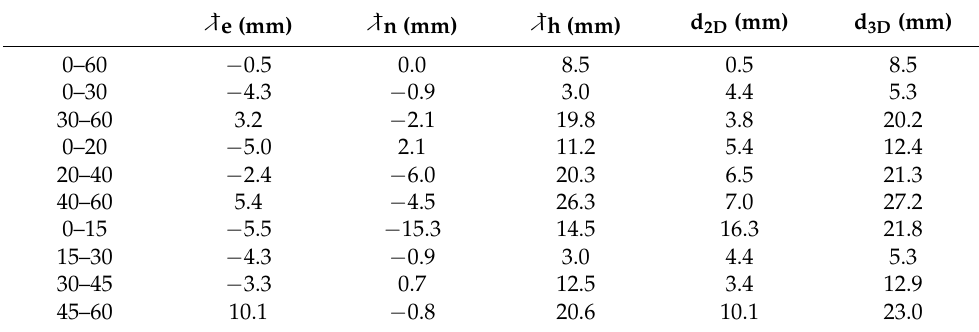
Table 1. Used parameters in the data processing. Table 5. Positioning performance results at ST 2.